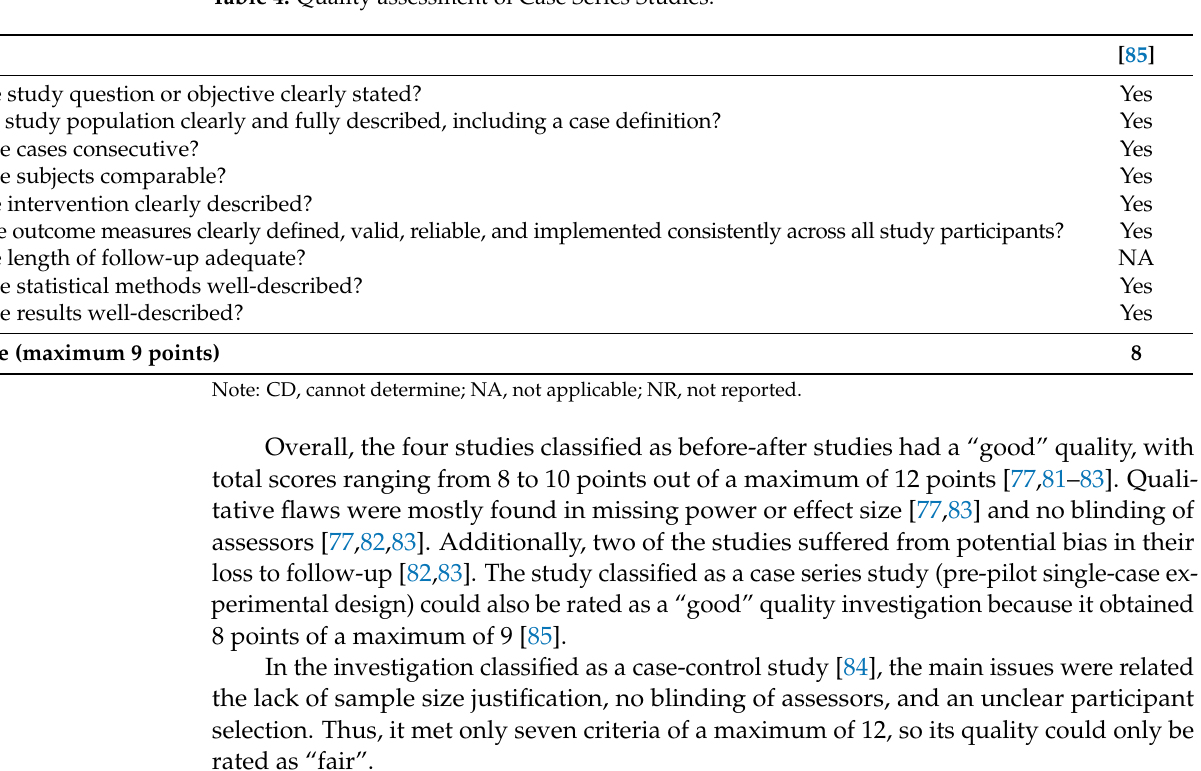
Table 4. Quality assessment of Case Series